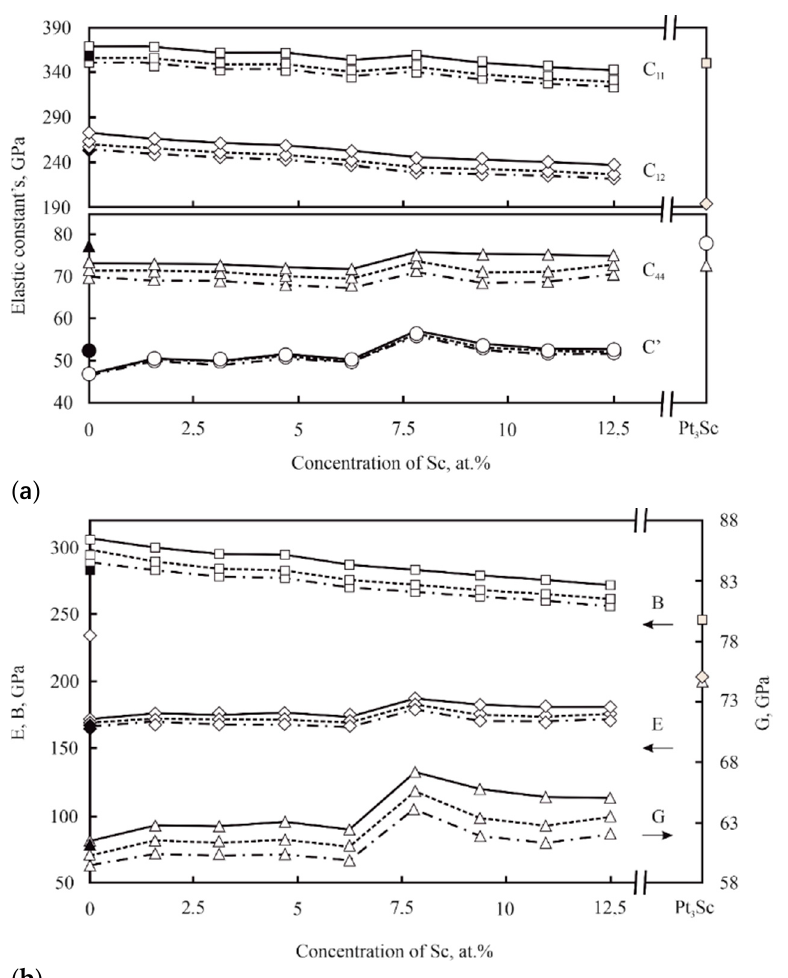
Figure 8. Calculated values of elastic constants ( a ); the bulk modulus B (open squares), Young’s modulus E (open diamonds), and shear modulus G (open triangles) ( b ) in Pt-Sc alloys and Pt 3 Sc compounds; solid and dotted lines represent the results of calculations using different approximations. Taken from Ref. [41] with permission from Elsevier. Copyright 2008, Elsevier.